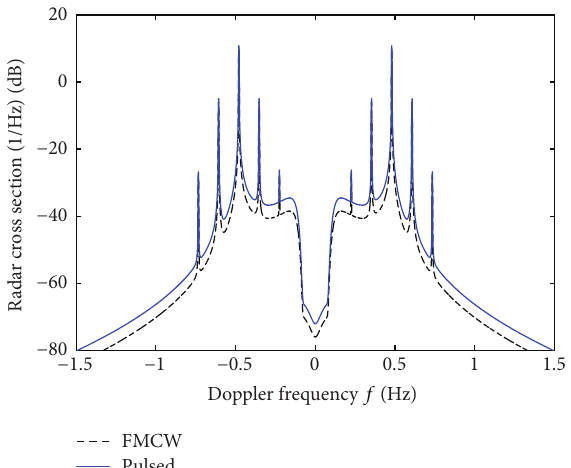
Figure 2: Comparison of the first-order radar cross sections for the FMCW waveform with that for the pulsed waveform.